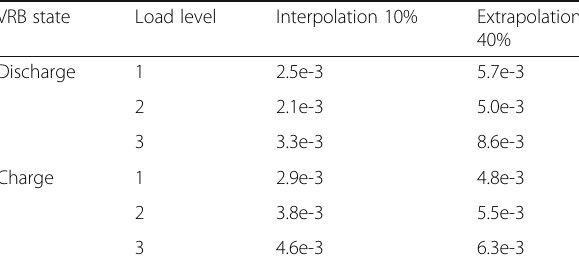
Table 7 Response residuals of interpolation and